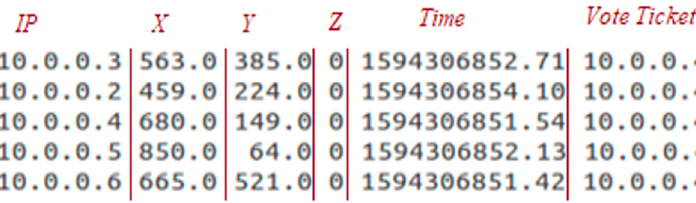
Figure 3. Position table in FWR protocol Stage I.